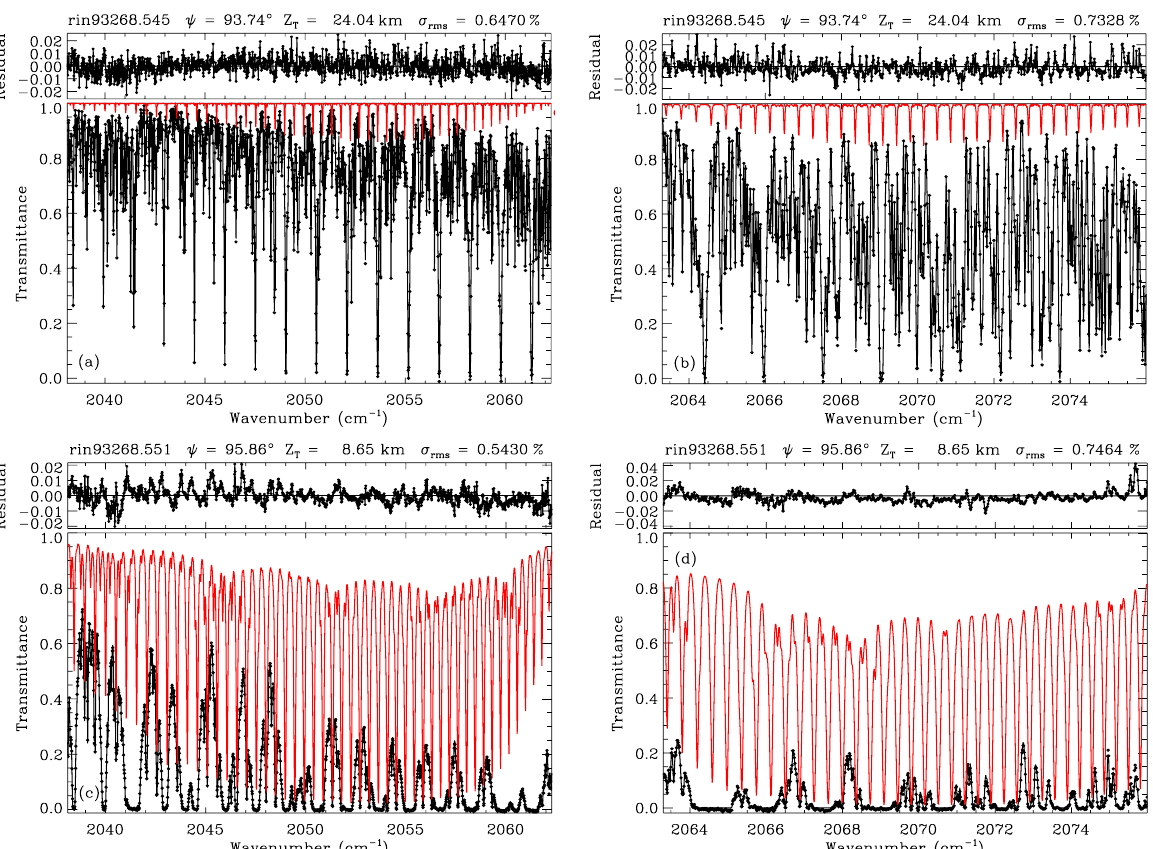
Figure 1. Examples of spectral fits to MkIV balloon spectra measured at 24.0km (a, b) and 8.7km (c, d) tangent altitude. Panels (a, c) show fits to the P -branch. Panels (b, d) show fits to the R -branch. Black points represent the measured spectra. The black line is the fitted calculation. The red line shows the OCS contribution to the fitted calculation. Interfering gases are primarily CO 2 , H 2 O, and O 3 . Figure S1 in the Supplement shows the same fits but with an expanded x -scale and with the individual interfering gases shown in different